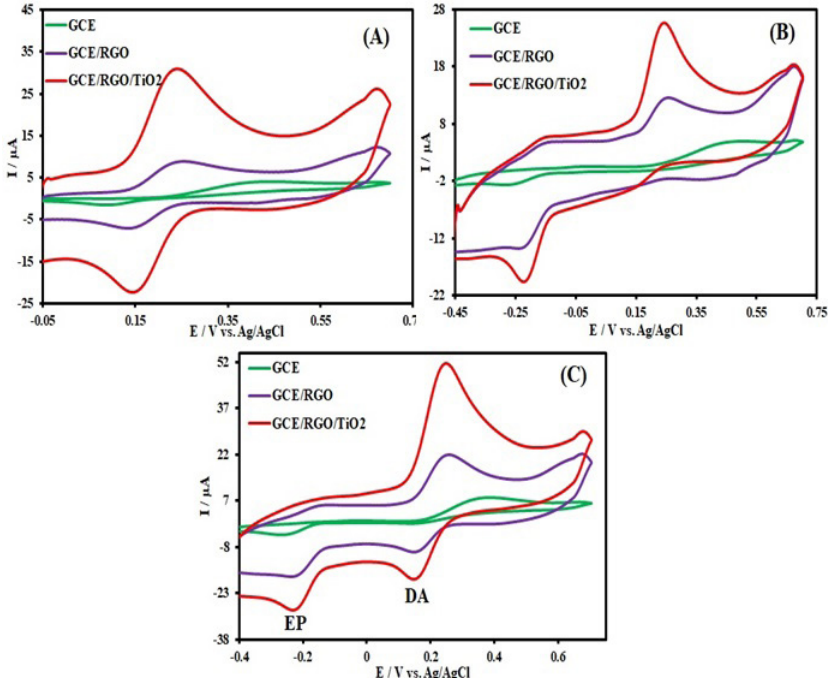
Fig. 7. Cyclic voltammograms of 500 µM DA (A), 500 µM EP (B) and a mixture of 500 µM DA and EP (C) at the surface of a bare GCE, GCE/RGO, and